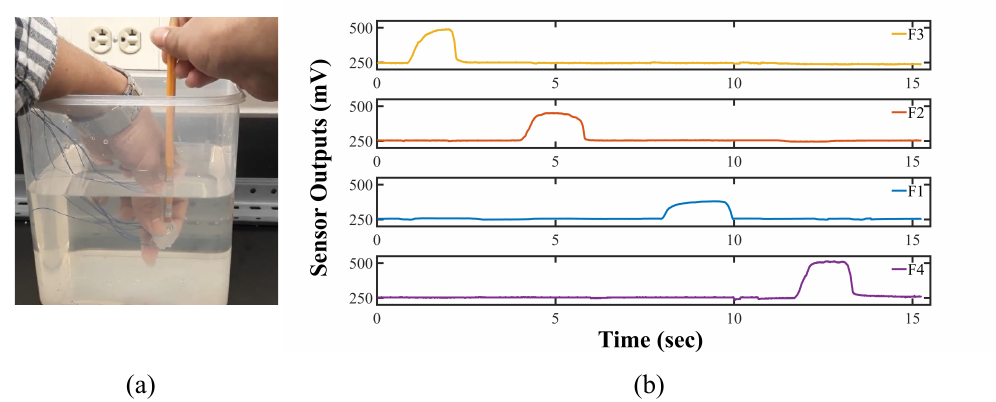
Figure 14. Underwater test for the sensor ( a ) exerting forces and ( b ) corresponding readings of the